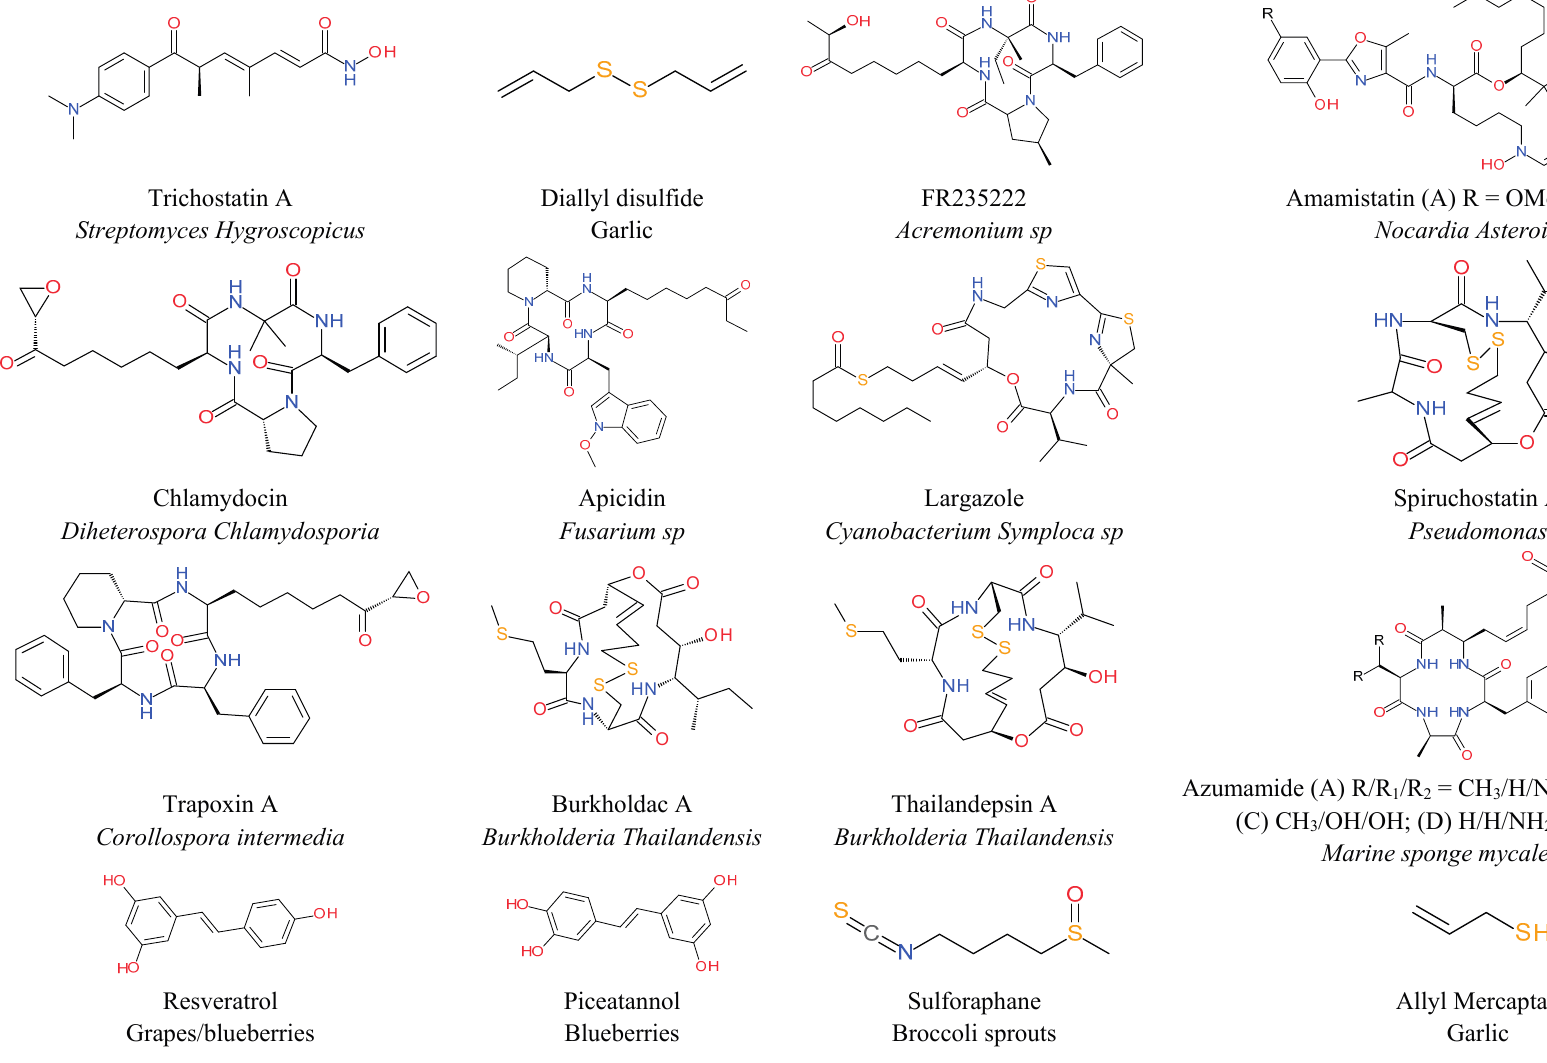
Figure 1. Natural product HDAC inhibitors and their